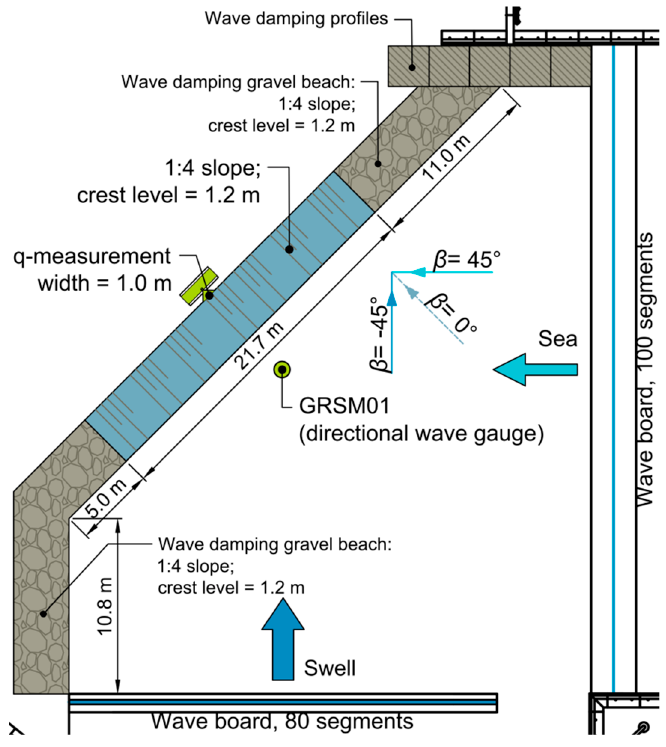
Figure 2. Model set-up in the wave basin.